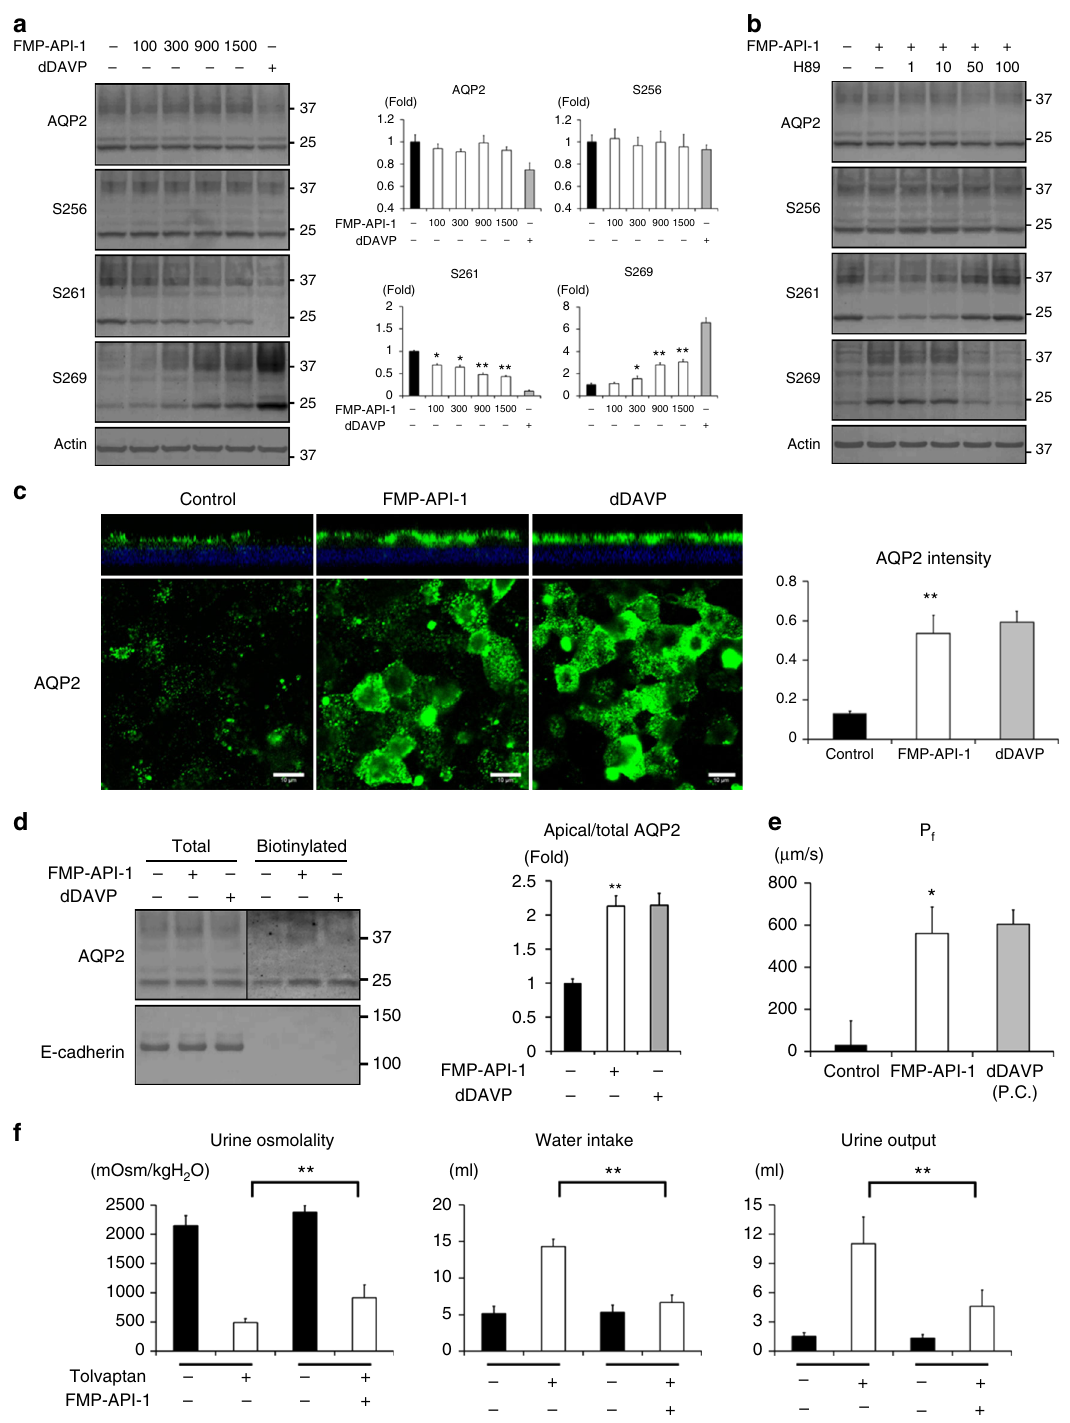
Fig. 6d, e). Hence, the long-term effects of FMP-API-1/27 may reduce nocturia frequency in patients with congenital NDI by self-injection of FMP-API-1/27 before bedtime. In addition to potency, drug speci fi city is an important pharmaceutical property. Although PKA is